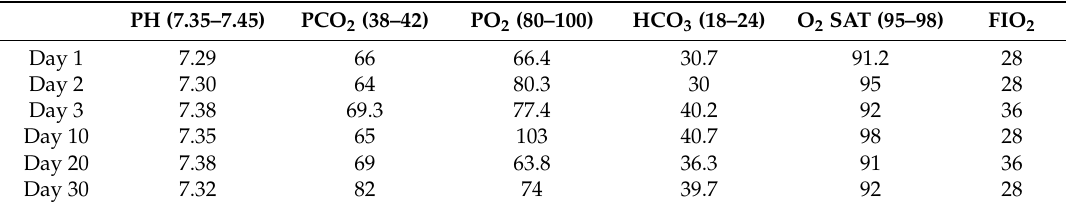
Table 1. Serial arterial blood gas report showing persistence of hypercapnia with development of compensated respiratory